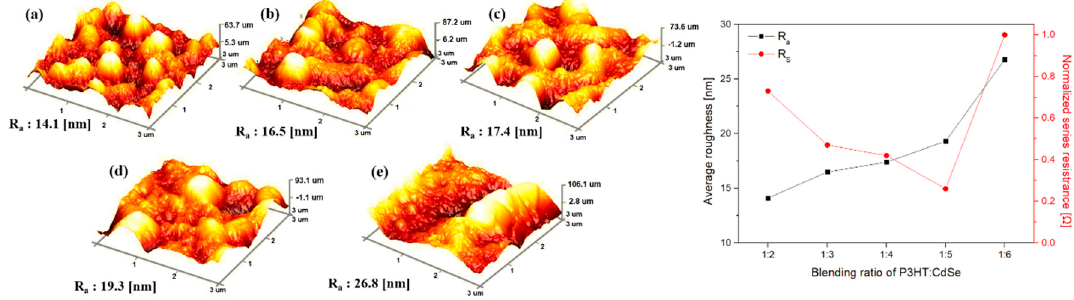
Figure 6. AFM images, average surface roughness (Ra) of the active layer under different blending ratios of P3HT:CdSe QDs of ( a ) 1:2, ( b ) 1:3, ( c ) 1:4, ( d ) 1:5, and ( e ) 1:6.